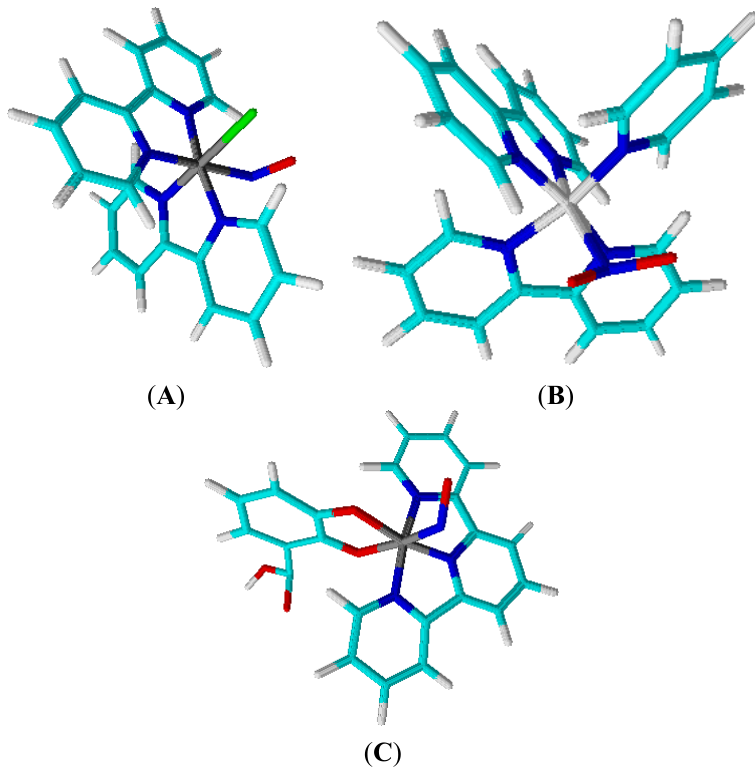
Figure 4. Chemical structure of polipyridines ruthenium complexes ( A ) cis - [RuCl(bpy) NO] 2+ , ( B ) cis -[Ru(bpy) (py)NO] 3+ and ( C ) [Ru(tpy)(NH.NHq)NO] 3+ . The 2 2 colored circles represent atoms in the chemical structure (cyan: Carbon; blue: Nitrogen; green: Chlorine; red: Oxygen; white: Hydrogen and gray: